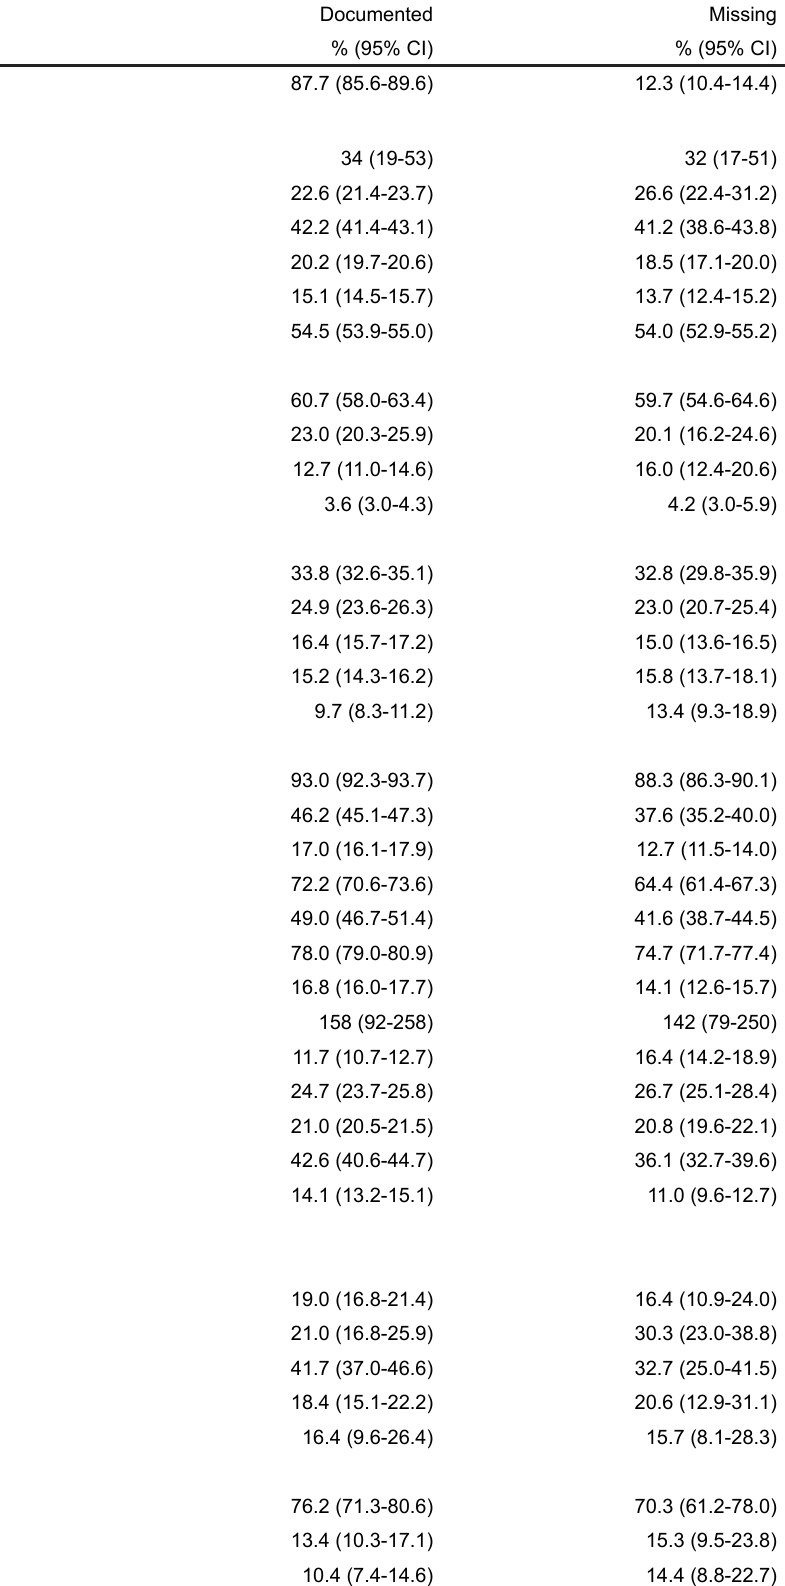
Table 4. Comparison of emergency department visits with triage acuity documented and missing. Characteristics